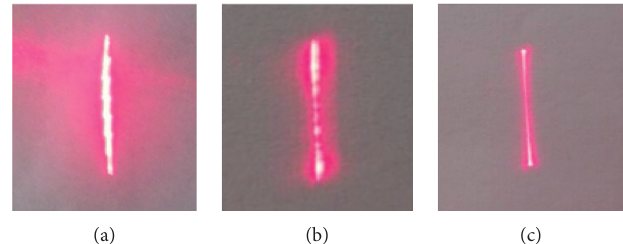
Figure 10: Screens captured in open control, in discrete PID control, and in discrete piecewise PID control. (a) Screen captured in open control; (b) screen captured in discrete PID control; (c) screen captured in discrete piecewise PID control.